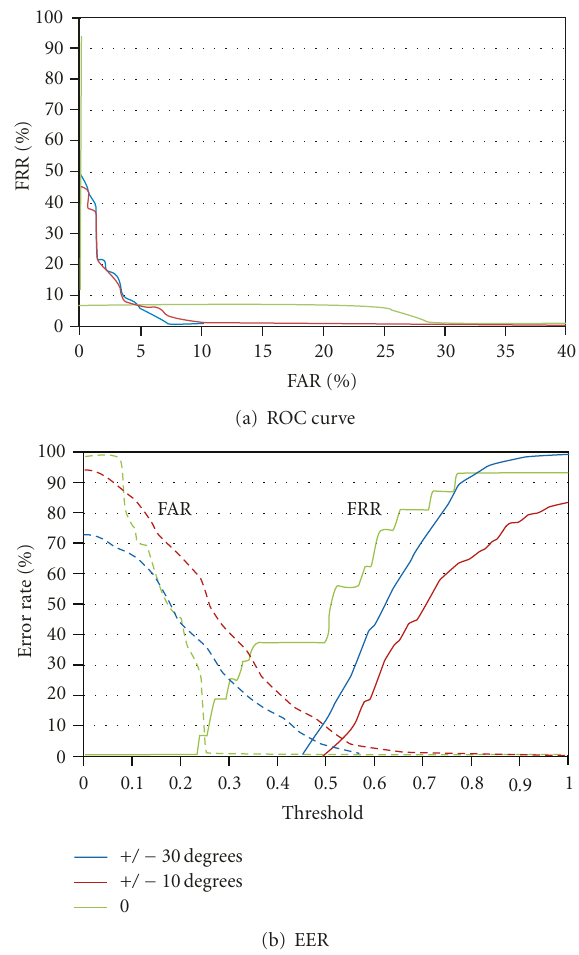
Figure 11: CIM database results.